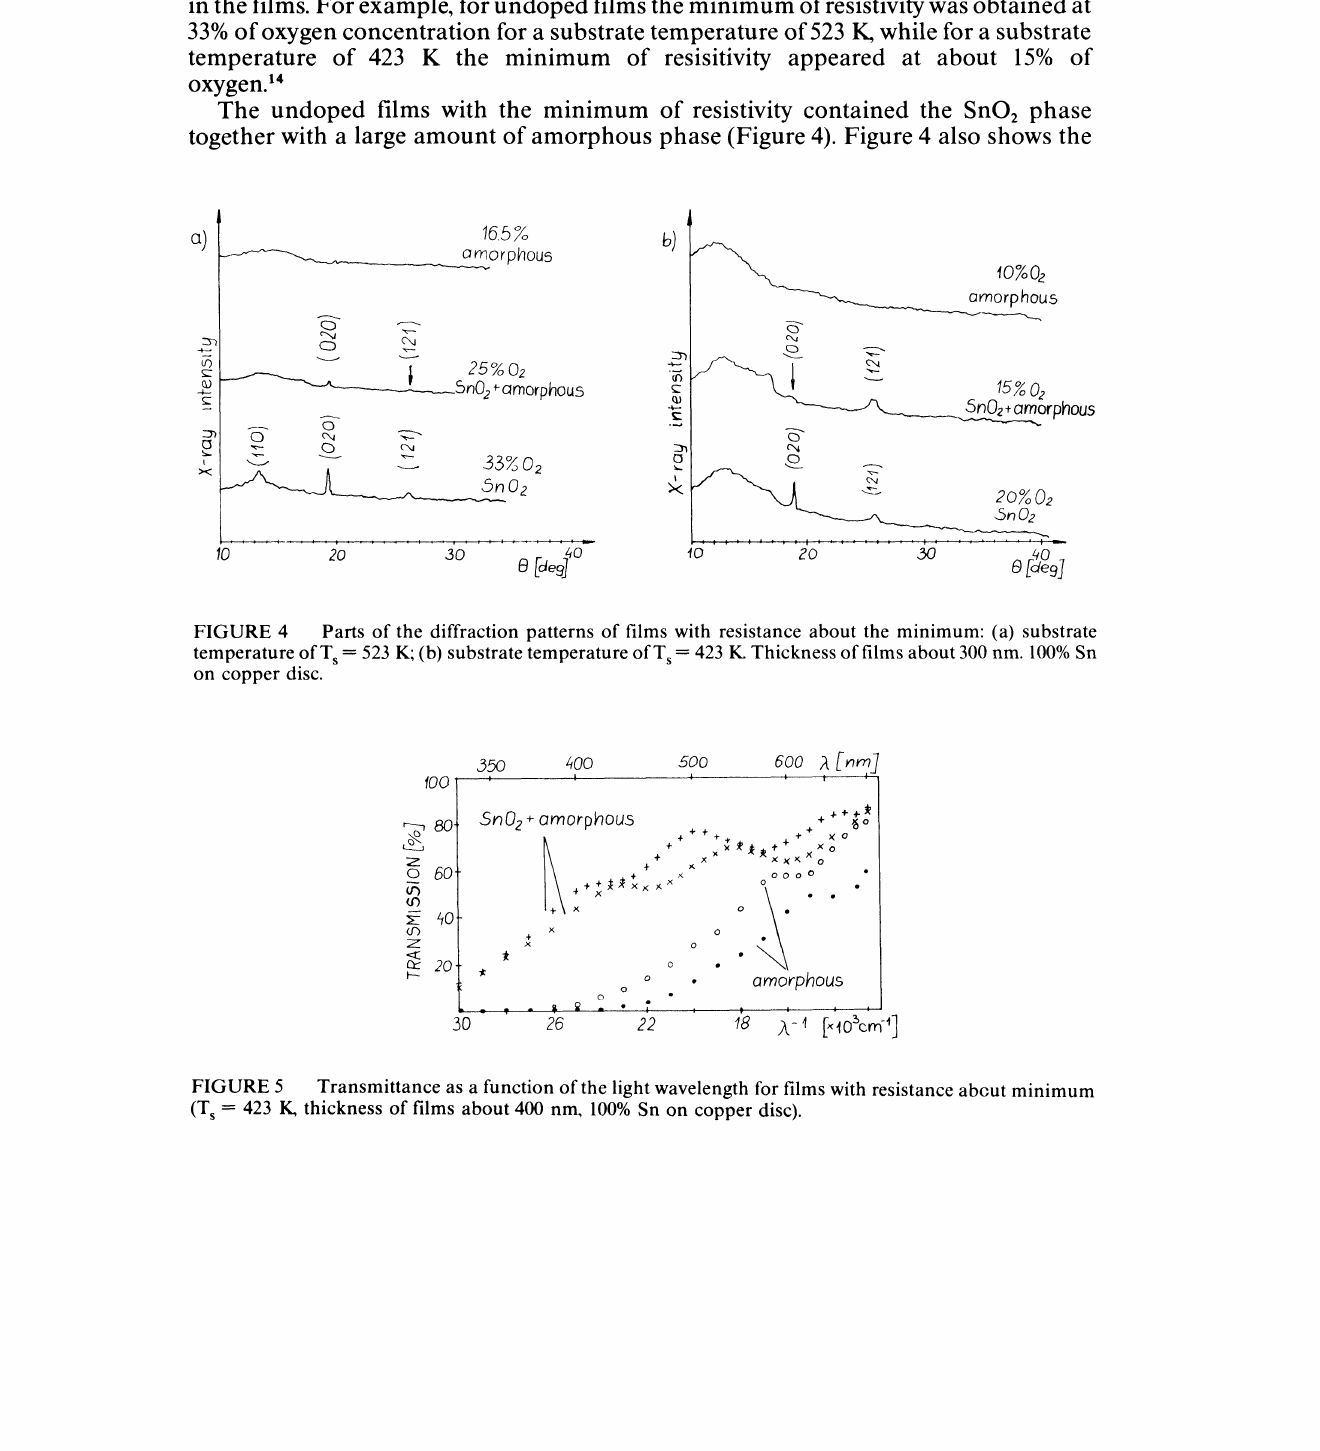
Transmittance as a function ofthe light wavelength for films with resistance abcut minimum (T 423 K, thickness of films about 400 nm, 100% Sn on copper